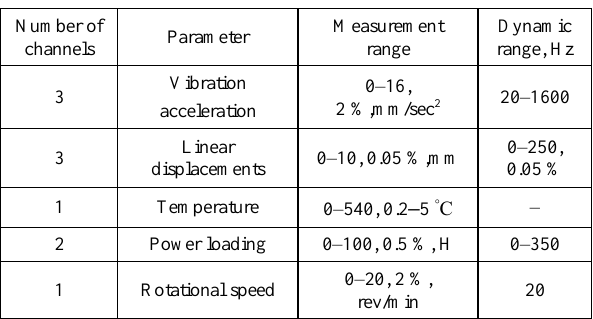
C HARACTERISTICS OF U SED C HANNELS